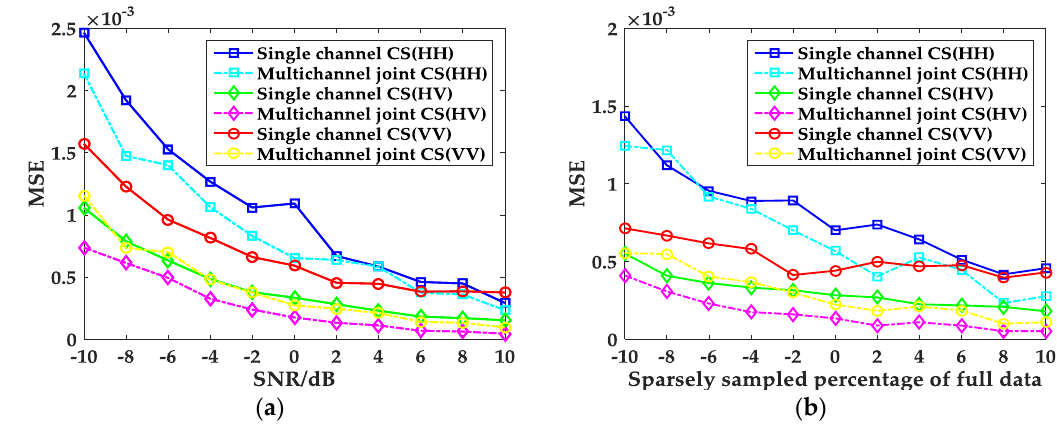
Figure 11. Relationship between the MSE of amplitude for each channel and SNRs and sparse samples. ( a ) SNRs; and ( b ) sparsely sampling percentage of full data.